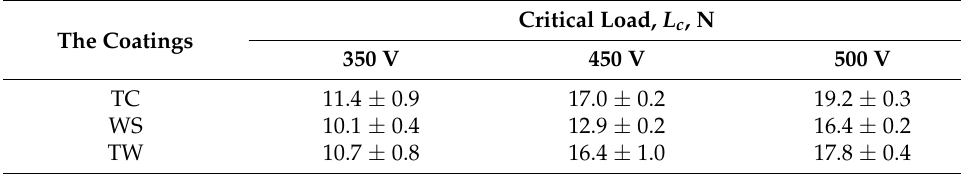
Table 3. Critical load for the coatings deposited at different process voltages.